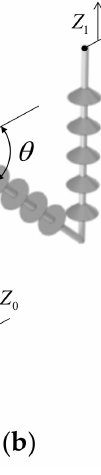
Figure 13. Model of ( a ) the curved cylindrical metamaterials and ( b ) the curved conical